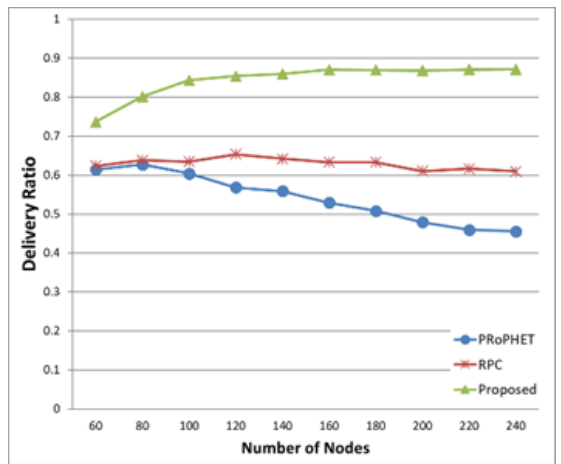
Figure 11. Delivery ratio for different number of nodes.